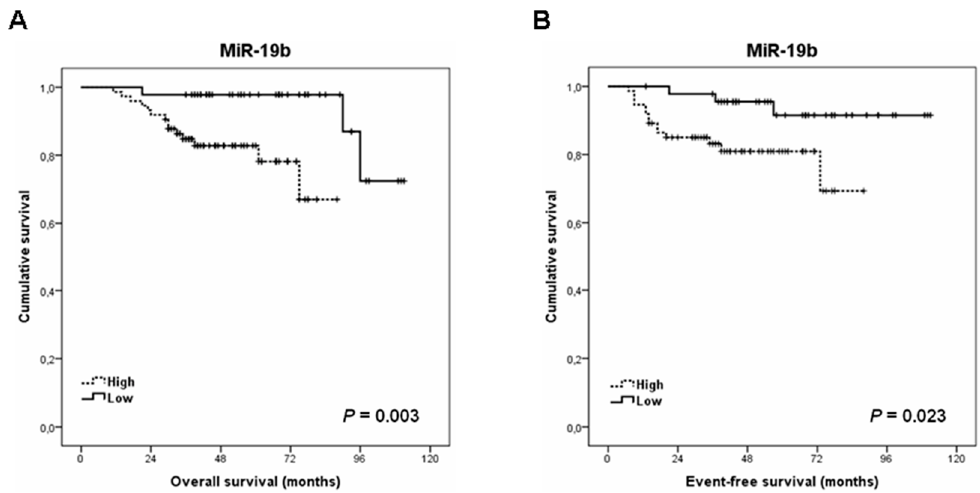
Figure 2. Clinical impact of miR-19b in LARC patient outcomes. Kaplan-Meier analyses for ( a ) overall and ( b ) event-free survival.